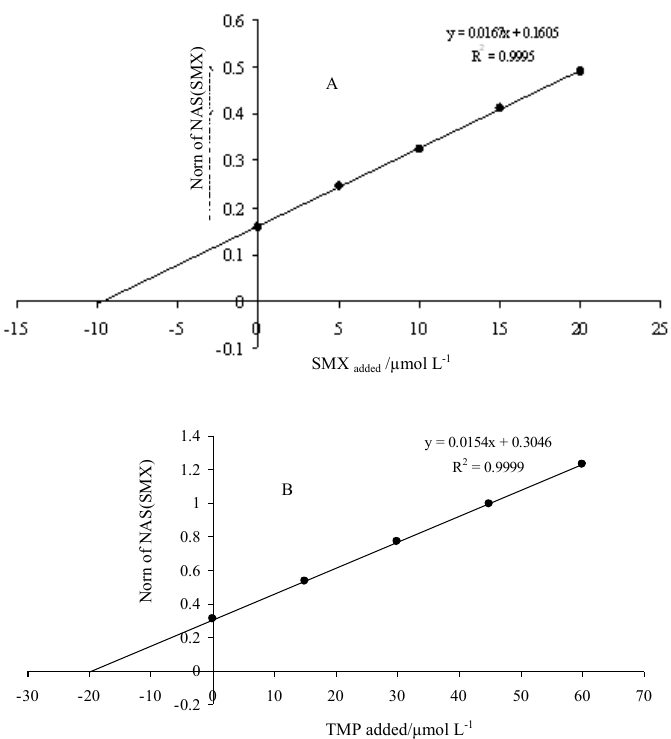
Figure 6. Plot of Norms of NAS mixtures of SMX ( 10 µmol L -1 ) and TMP ( 20 µmol L -1 ) at pH